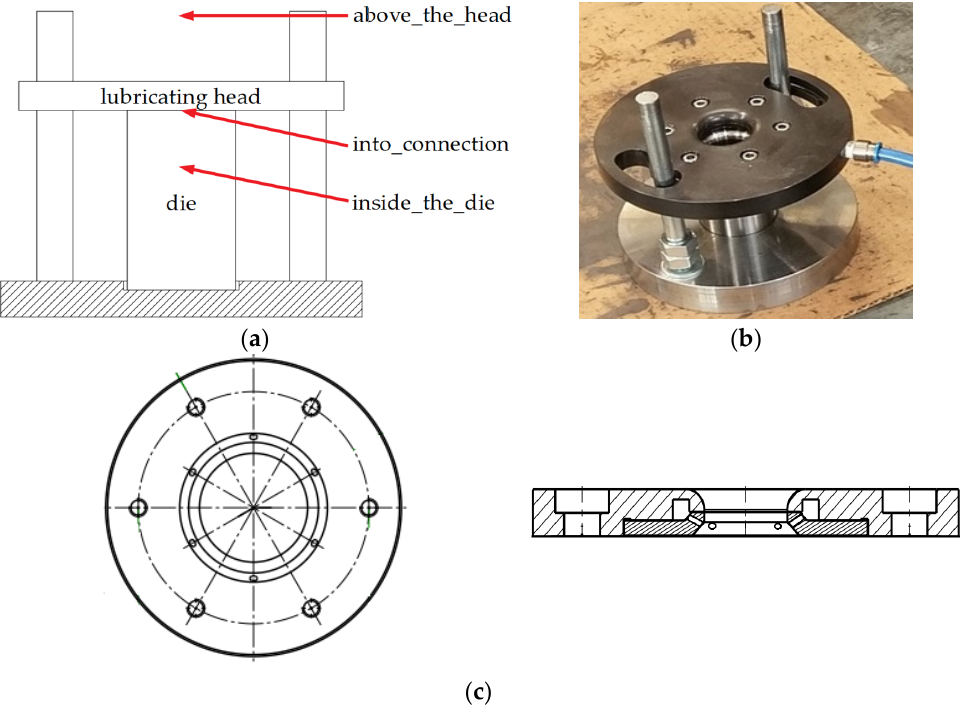
Figure 4. Test stand diagram: ( a ) schematic diagram; ( b ) test stand; ( c ) lubricating head diagram. After each test, each surface of the laboratory stand was thoroughly cleaned. In la- boratory and industrial tests, the same lubricating head shown in Figure 4c was used. This head is characterized by six nozzles through which lubricant was pushed out. The nozzles in the form of holes are placed at an angle, thanks to which lubricant is supplied inside the die; they minimize the amount remaining on the connection of the lubricating head and the die.